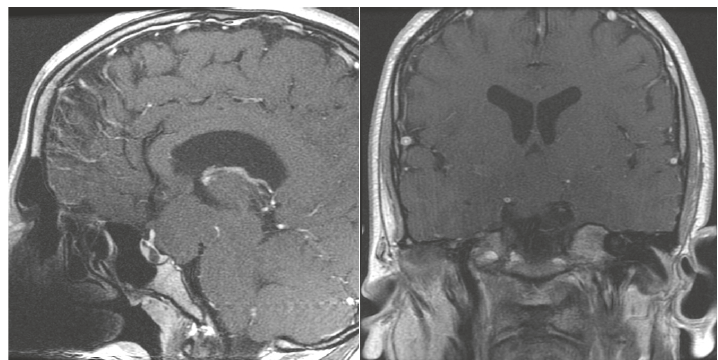
Figure 1: Sagittal and Axial MRI with contrast showing isointense, nonenhancing hypothalamic